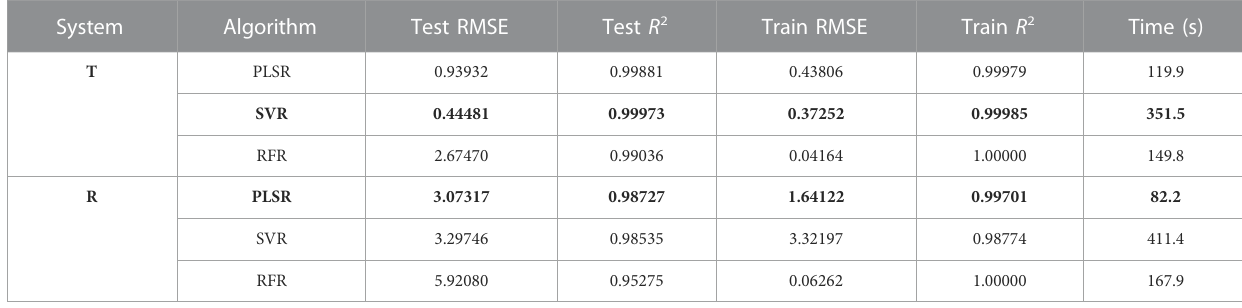
TABLE 4 Modeling results using different regression analysis algorithms.